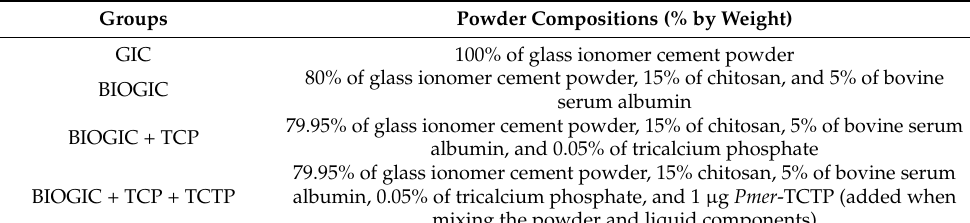
Table 1. Components of each cement powder.